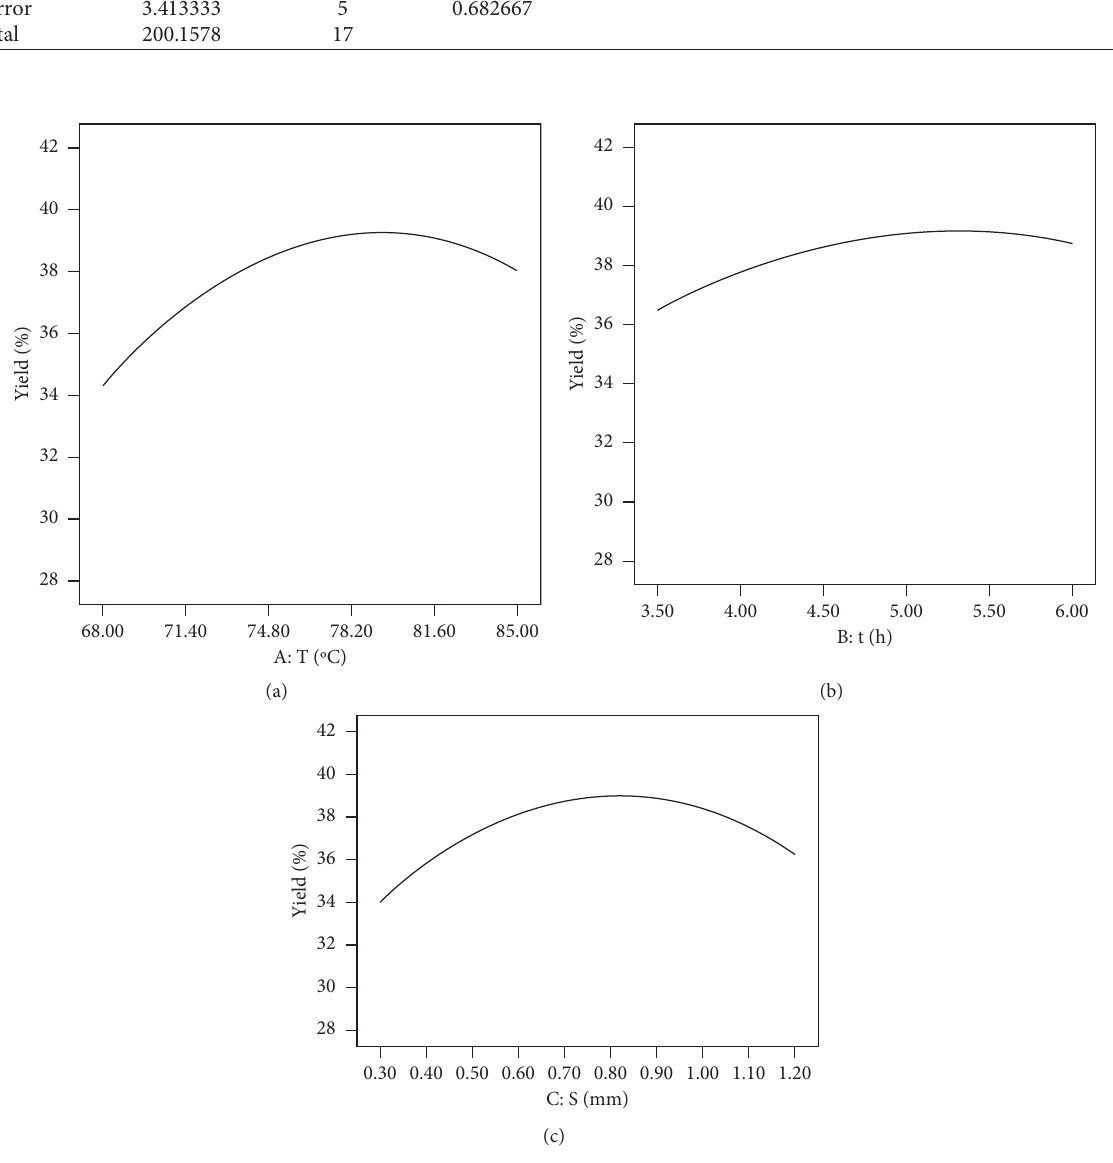
Figure 3: Individual effect of parameters. (a) Extraction temperature. (b) Extraction time. (c) Particle size effect on